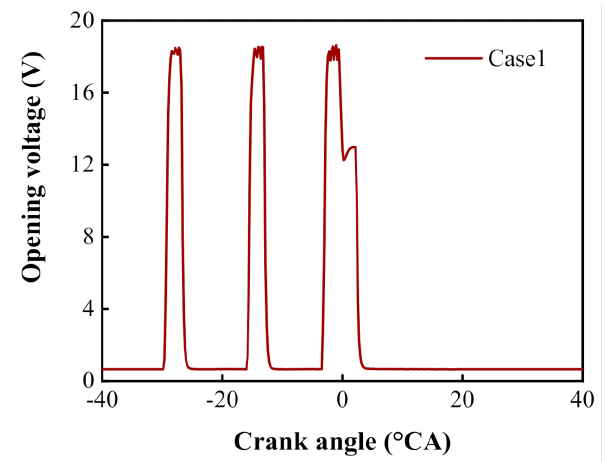
Figure 2. Injection pulse.